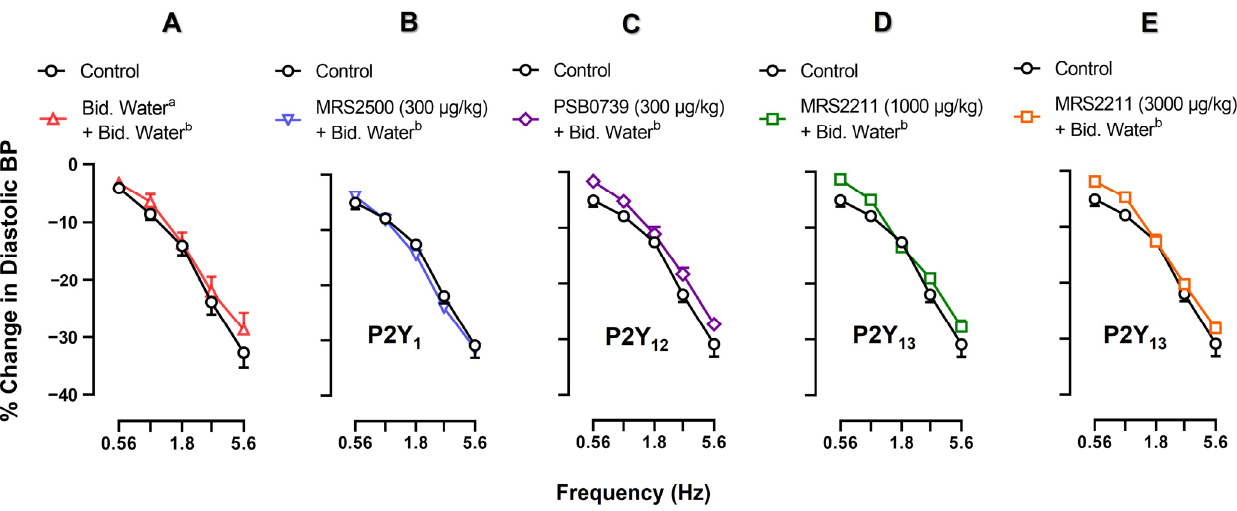
Figure 2. Comparative analysis of the effect of vehicle (bidistilled water) or P2Y receptor antagonists on the neurogenic vasodepressor responses produced by spinal (T 9 –T 12 ) electrical stimulation. Effect of i.v. bolus injections (after 10 min) of ( A ) bidistilled water a (1 mL/kg; ), ( B ) MRS2500 (300 μ g/kg; ), ( C ) PSB0739 (300 μ g/kg; ), ( D ) MRS2211 (1000 μ g/kg; ) or ( E ) MRS2211 (3000 μ g/kg; ) on sensory CGRPergic drive during an i.v. continuous infusion (after 10 min) of bidistilled water